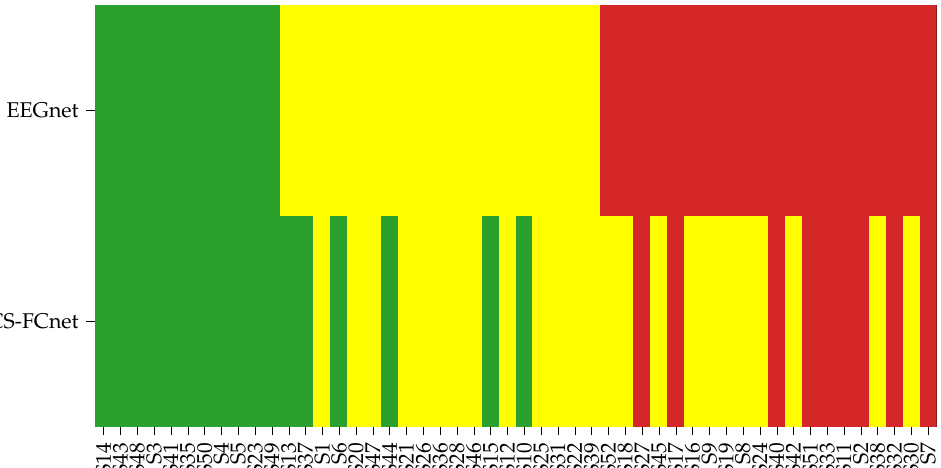
Figure 5. KCS-FCnet subject group enhancement regarding the EEGnet performance. Note that green, yellow and red represent best, medium, and worst performance regarding the average accuracy along subjects. First row: Subjects organized based on the EEGnet classification. Second row: Subject membership changes based on the KCS-FCnet